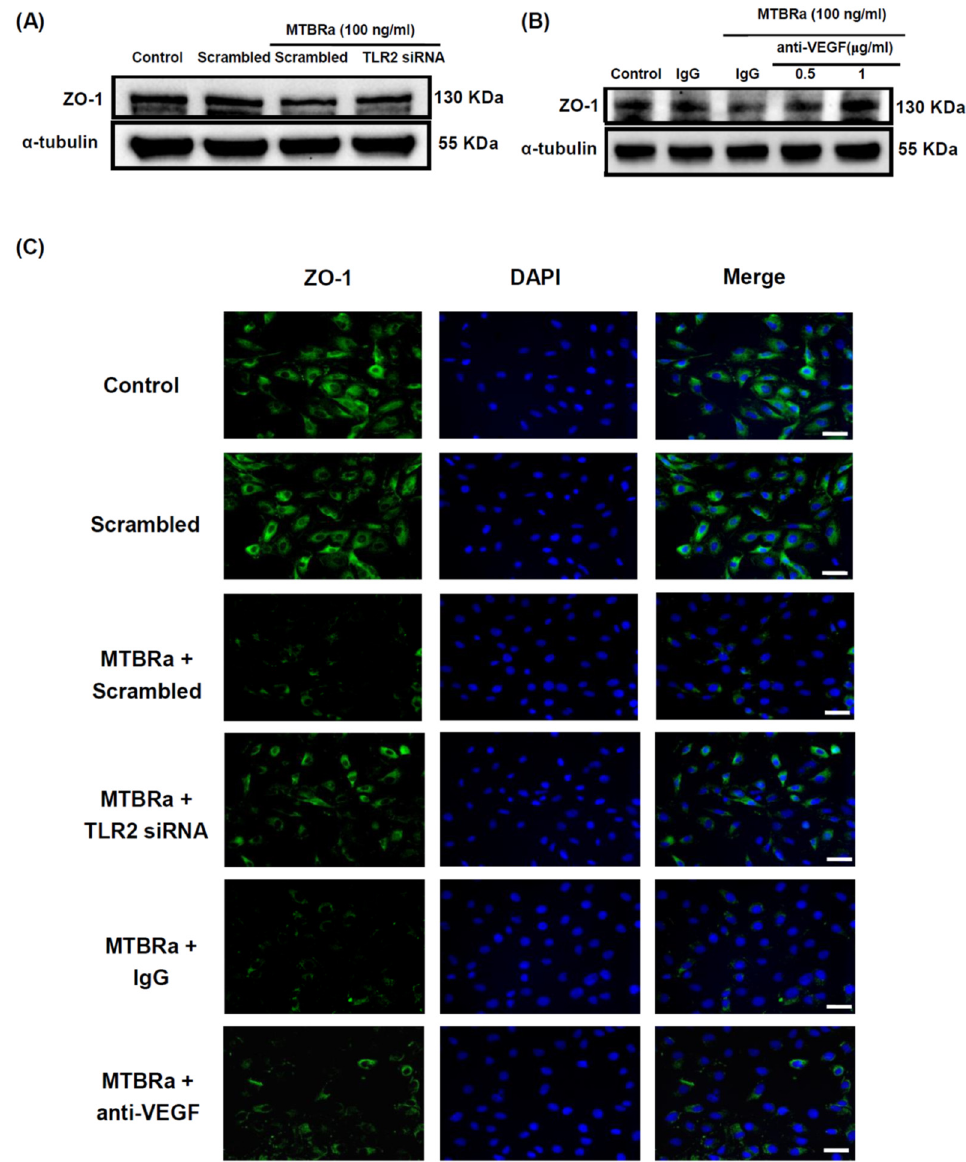
Figure 7. MTBRa downregulates ZO-1 expression through TLR2/VEGF signaling in human PMCs. MeT-5A cells were transfected with scrambled siRNA or TLR2 siRNA for 48 h or pretreated with IgG isotype control or anti-VEGF neutralizing antibody for 15 min, followed by MTBRa treatment for 24h. Expression of ZO-1 was assayed by ( A , B ) Western blotting or ( C ) confocal immunofluorescence analysis (green). Cells were co-stained with 4 ′ ,6-diamidino-2-phenylindole (DAPI) for exhibition of the nuclei (blue). Scale bar, 30 µm. Data represented three individual experiments. MTBRa, Mycobacterium tuberculosis H37Ra; PMC, pleural mesothelial cell.